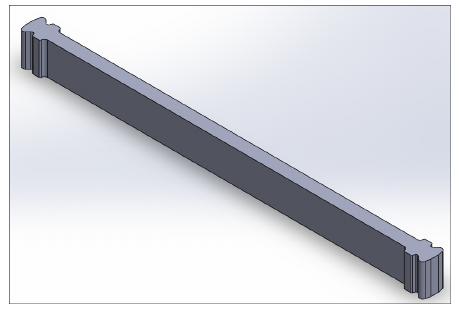
Figure 1. 3D model of dummy blade with dovetail joints at both ends.